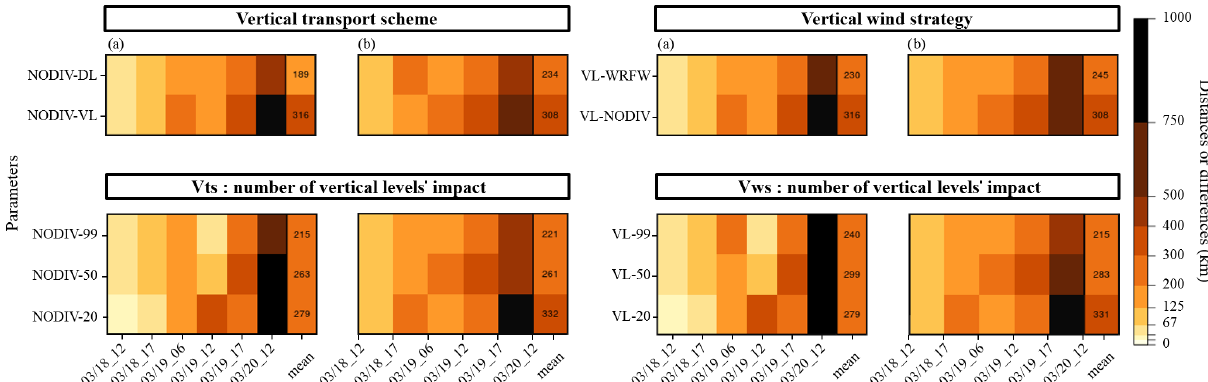
Figure 5. The left column shows the impact of the vertical transport scheme. The right column shows the impact of the vertical wind strategy. (a) Gap between the satellites and CHIMERE SO 2 plume centroids. (b) Differences between the SO 2 plume centroids’ trajectories. To produce this figure, differences (in km) between the model and satellite plumes’ centroids were calculated for each simulation, and the impact of each parameter was then evaluated by calculating the mean between the simulation and satellite differences. For instance, “NODIV- DL” (first line, left column) is the mean between “NODIV-DL-20”, “NODIV-DL-50” and “NODIV-DL-99”; “NODIV-99” (third line, left column) is the mean between “NODIV-DL-99” and